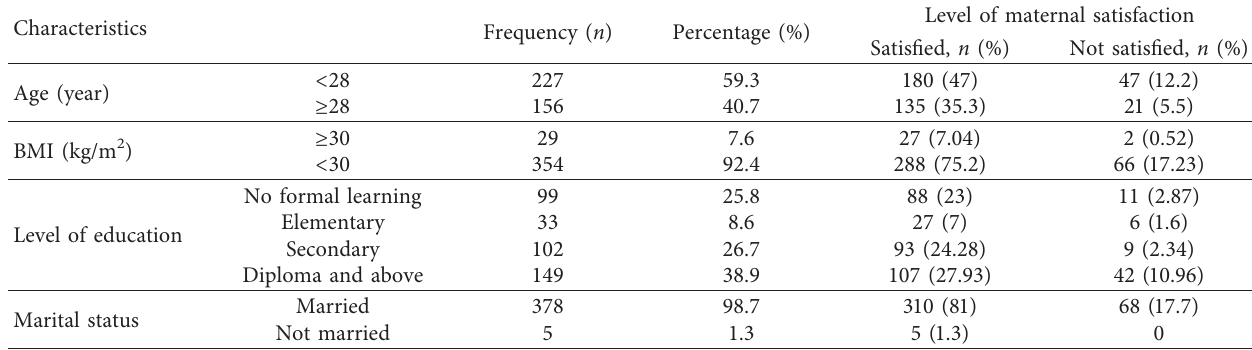
Table 1: Sociodemographic characteristics of parturients at University of Gondar Comprehensive Specialized Hospital, Northwest Ethiopia, 2019 ( N � 383).